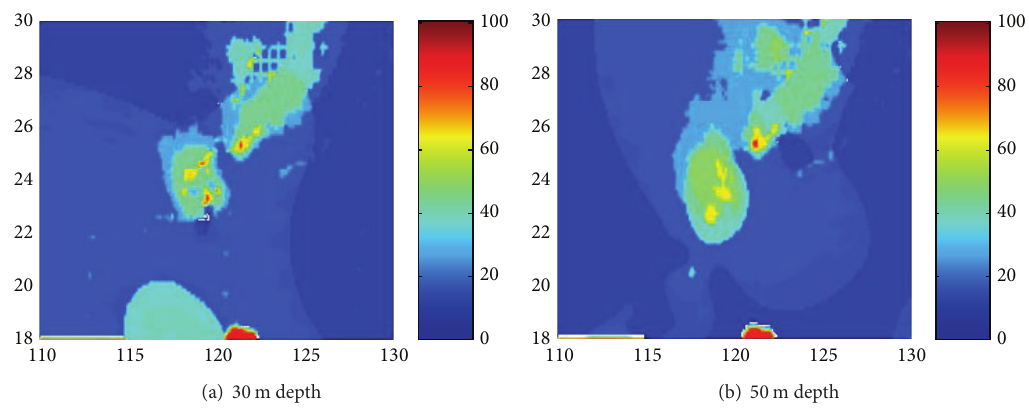
Figure 7: Safety situation